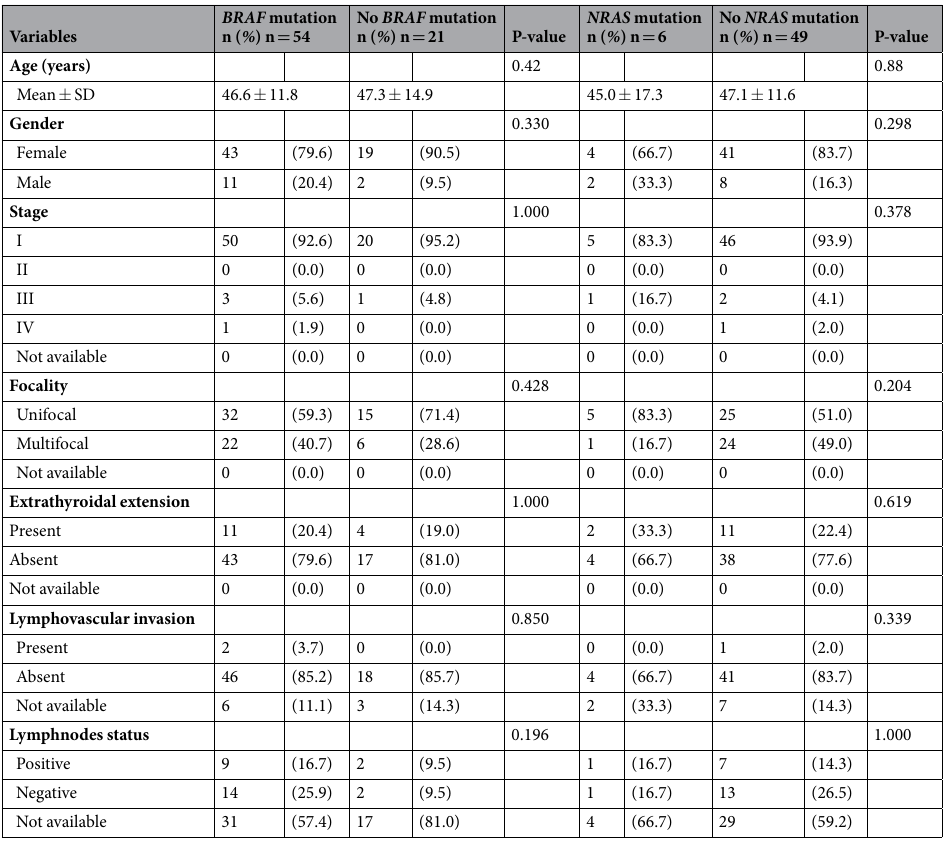
Table 3. Clinicopathological features of PTMC cases with respect to BRAF and NRAS mutations. * Significant